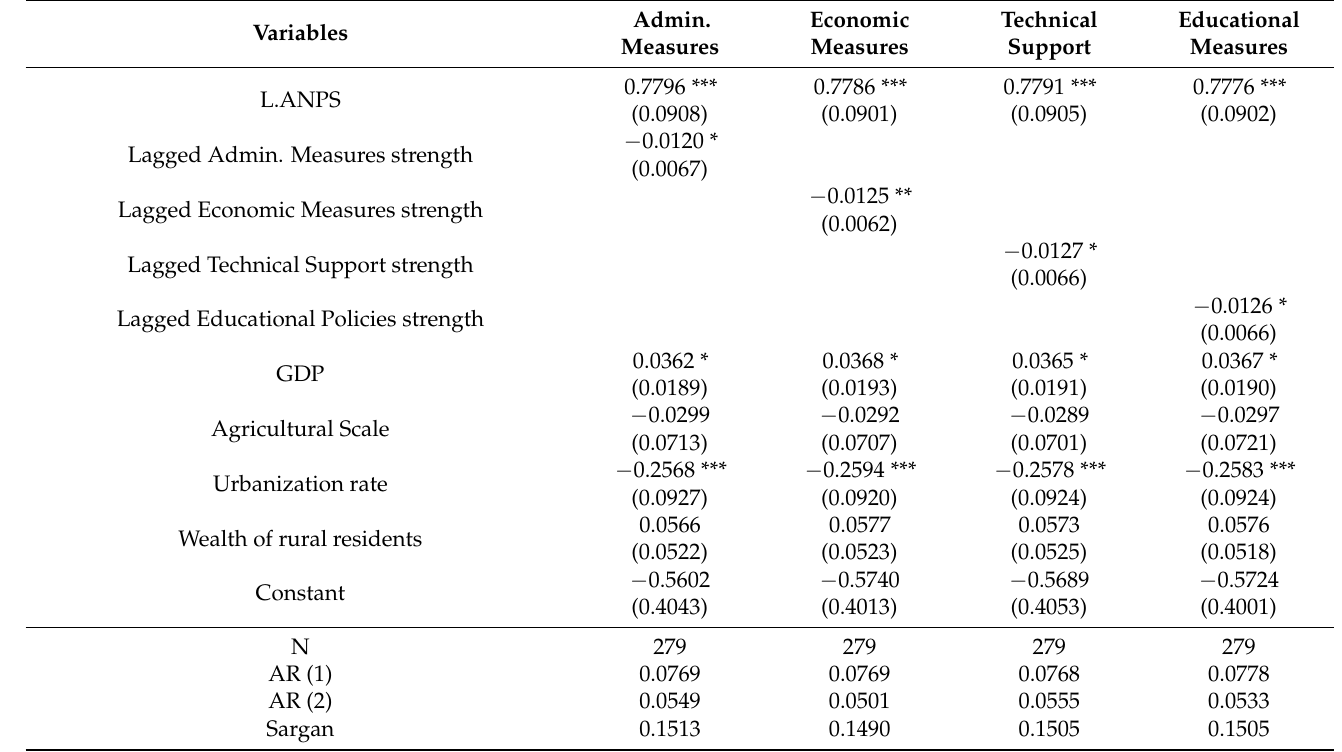
Table 7. Regression results of effects of policy with different measures on ANPS